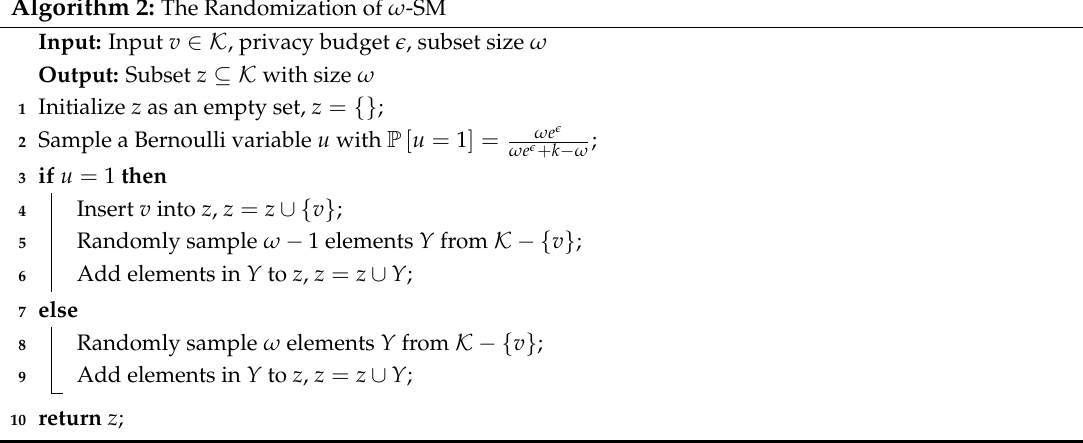
Algorithm 2: The Randomization of ω